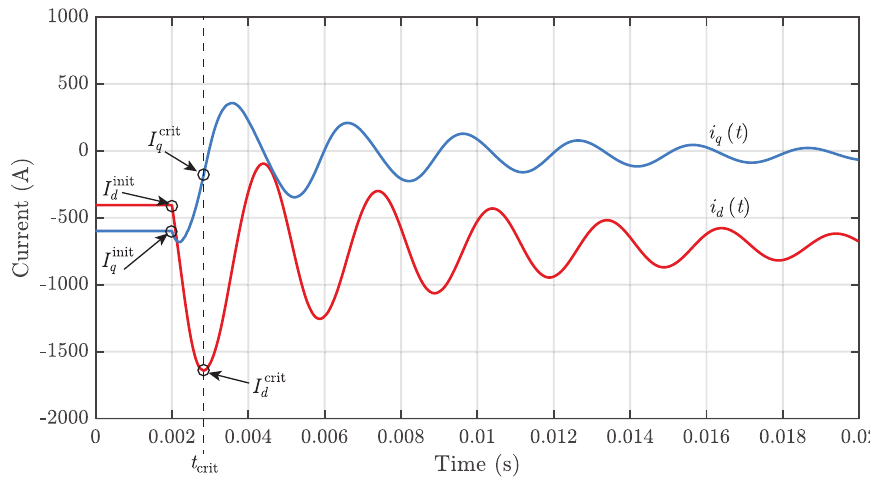
Figure 13. Three-phase short circuit for worst-case operation point (56Nm, 5000min − 1 ), where = − 405A and I init = − 599A. I init q d